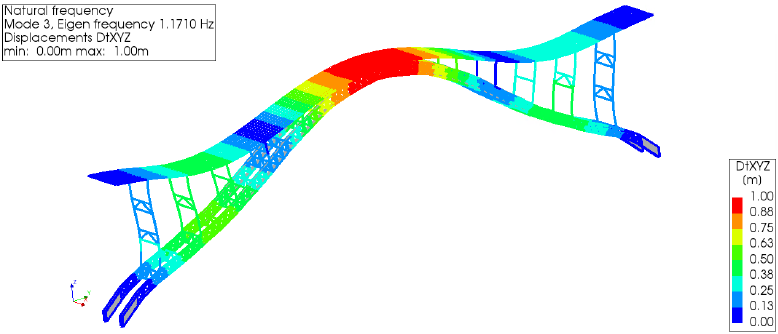
Figure 7. The first-order positive symmetric vertical bending mode of the bridge case by DIANA.